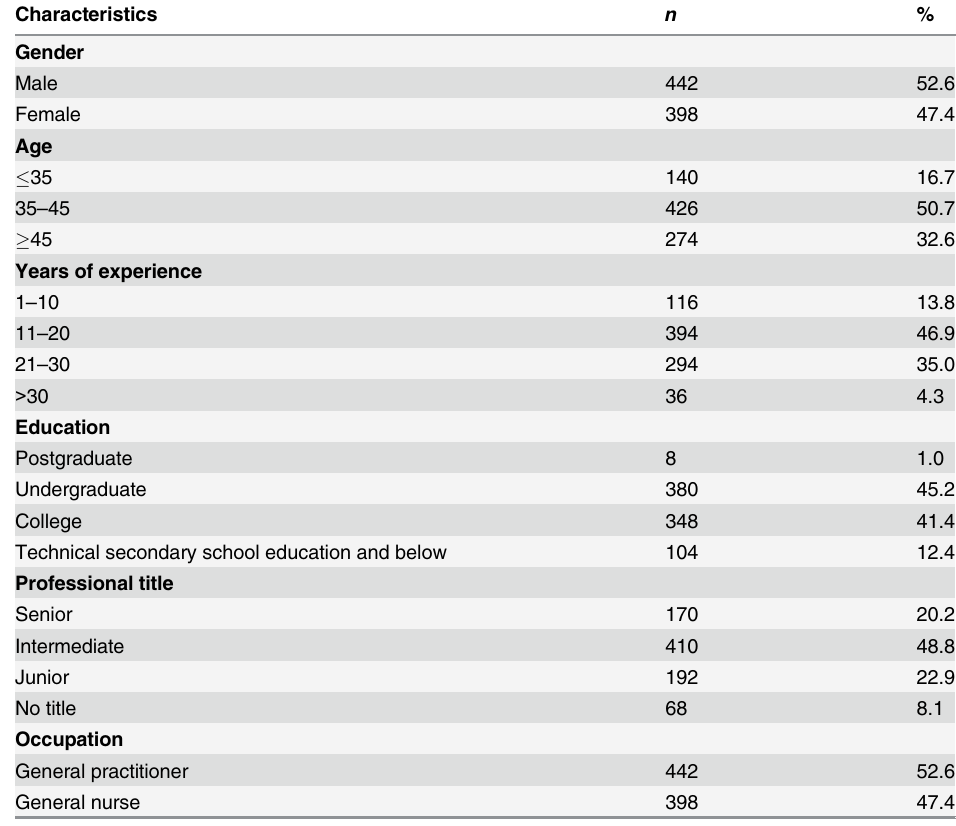
Table 1. Demographic characteristics of the respondents ( N =